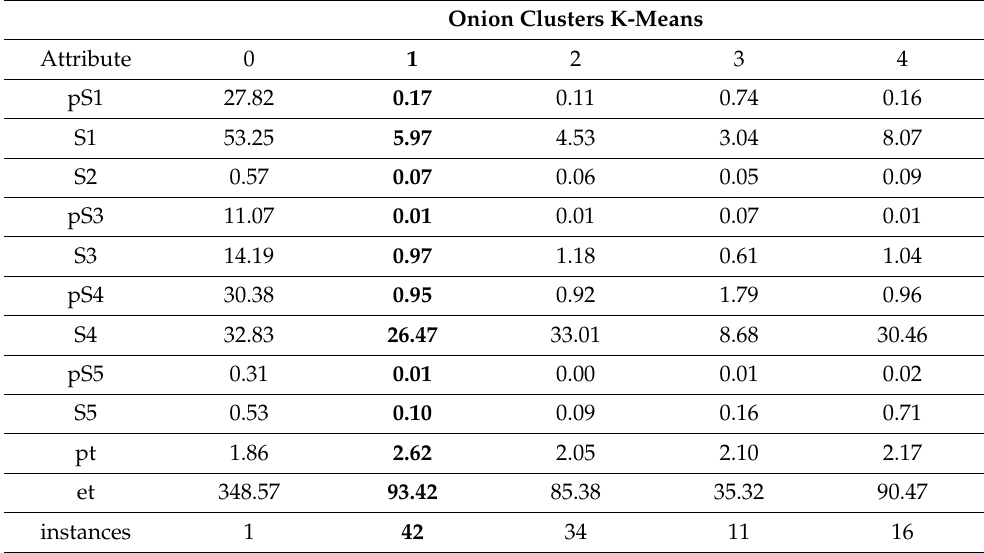
Table 4. The k-means clusterization results of the centroids of parameters of the chosen stages.